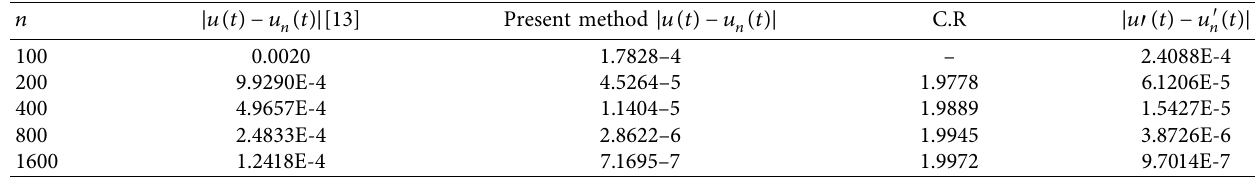
Table 2: Comparisons of the results of Example